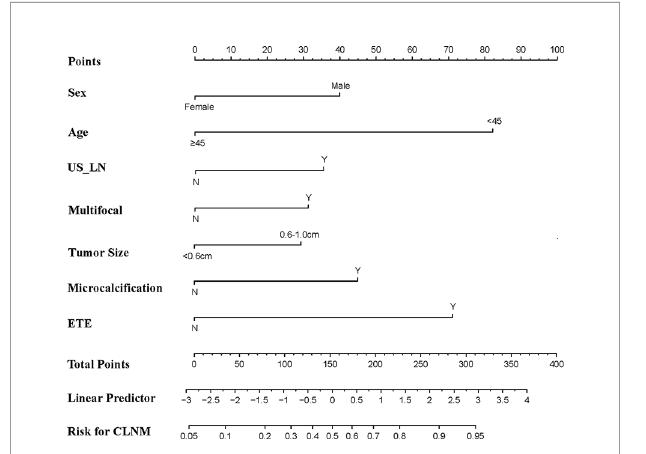
FIGURE 3 | ROC curve analysis to predict CLNM in PTMC